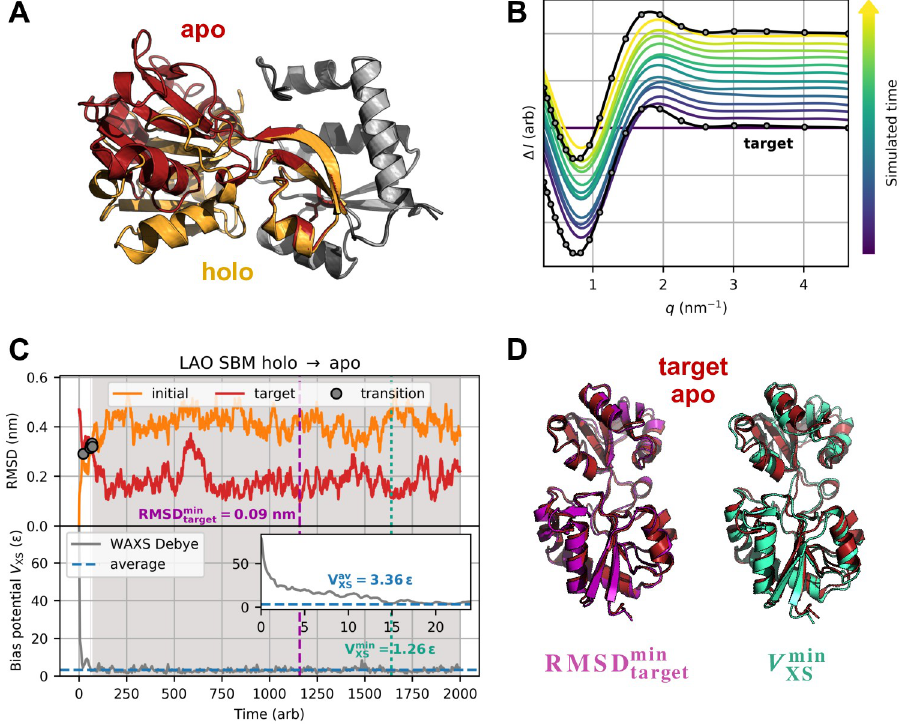
Fig 3. Method validation using the example of LAO protein’s holo-to-apo transition. Results are shown for parameters ( T , k χ ) = (50, 9 � 10 − 11 ε ). (A) LAO protein test system. LAO protein undergoes a large-scale conformational transition upon ligand binding, meaning the lobes are clearly separated in the unliganded state (apo form, red), whereas in mutual contact with lysine ligand bound (holo form, orange). Congruent parts in holo and apo conformation are depicted in grey. (B) Artificial target data for the holo-to-apo transition (grey circles). 20 q points between 0.3 nm − 1 and 4.6 nm − 1 were included. Theoretical difference intensities of simulated structures (blue to yellow) were plotted with small offsets and approached the target curve in the course of the simulation. (C) Initial and target RMSD (top) and bias energy (bottom) versus simulated time. The refinement involved one instantaneous transition from initial holo to target apo state in terms of intersecting RMSD curves (grey dots). With the simulation approaching its designated target state, the bias potential minimized accordingly. (D) Best structures as measured by target RMSD and bias potential. RMSD min structure (purple) and V min structure (turquoise) exhibit target RMSDs of target XS 0.09 nm and 0.16 nm,